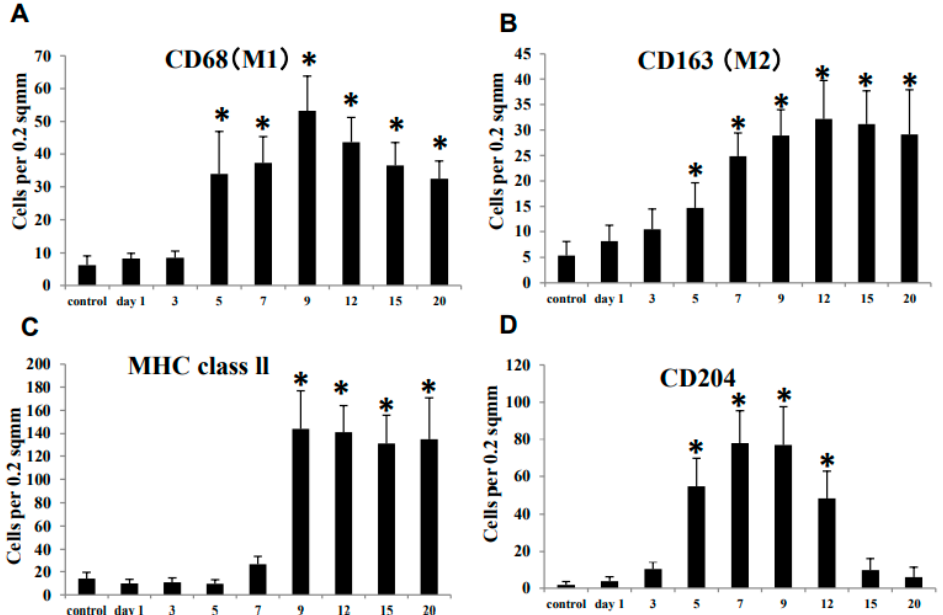
Figure 3. Evaluation of interstitial fibrosis of CDDP-induced rat renal lesions. ( A ) The azan–Mallory stain; in the control kidneys, collagen fibers are not seen in the interstitium (fibrosis degree, − ). ( B ) The azan–Mallory stain; on day 20, severe fibrosis (fibrosis degree, 4+) (arrows) is seen in the interstitium. ( C ) Immunohistochemistry for α -smooth muscle action ( α -SMA); α -SMA-positive myofibroblasts are seen in the increased fibrosis (fibrosis degree, 4+) (arrows). Bar = 50 µ m. ( D ) The percentage of α -SMA-positive area in the control and CDDP-injected rats on days 1 to 20; Dunnett’s test, *, significantly different from controls at p < 0.05.